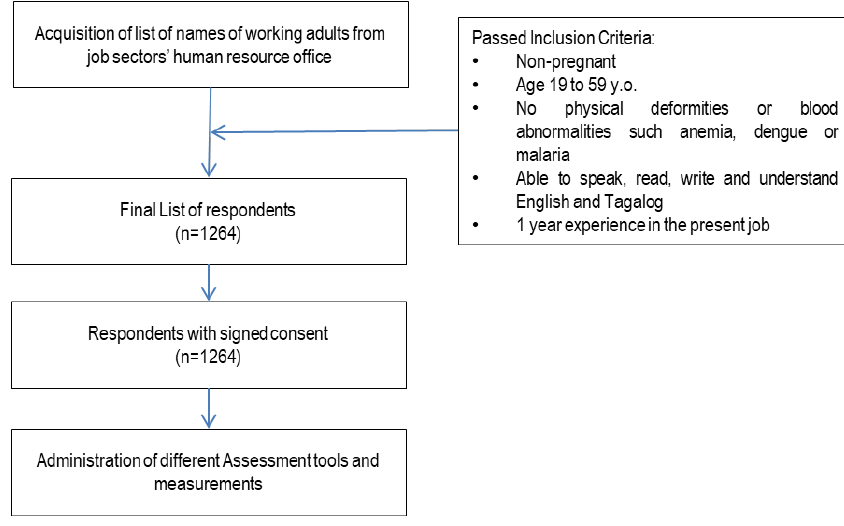
Figure 1. Study design.